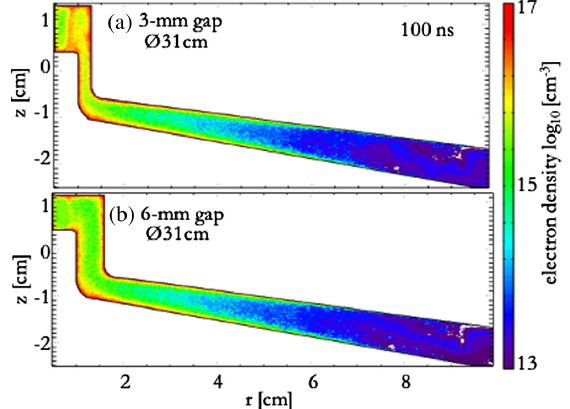
FIG. 7. 2D simulation geometries for the two ∅ 31 cm- convolute inner MITLs identified by their AK gap widths at z ¼ 0 of (a) 3 mm and (b) 6 mm. The electron density contours are also plotted in each figure at 100 ns.